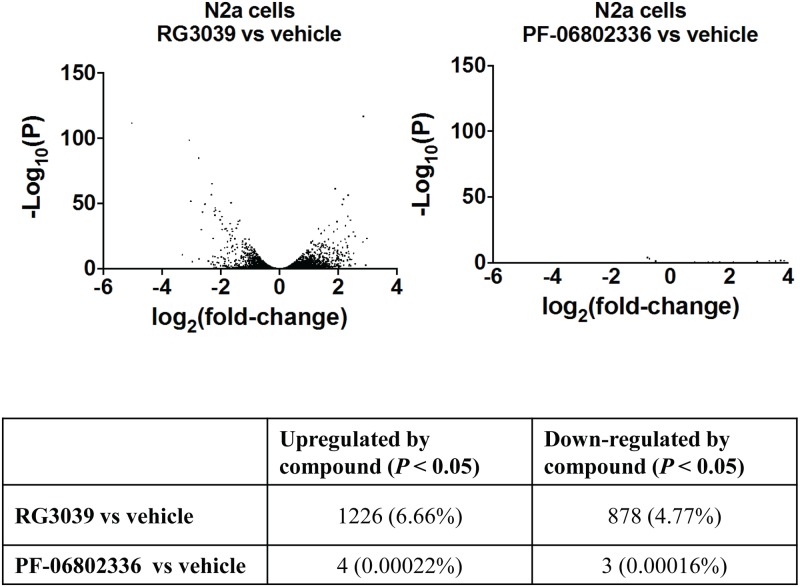
Volcano plots of differentially regulated genes detected by RNA-Seq analysis of N2a cells treated with RG3039 or its 7-methyl analog PF-06802336 with summary of number of genes significantly (P<0.05) changed.Plates of cells (in quadruplicate) were treated with 1 μM of either compound or DMSO (1 μM) for 24 hours before isolation of polyA RNA and RNA Seq analysis. In each case, the—Log10 of the corrected P value for the difference between compound- and DMSO-treated samples for each detectable gene was plotted vs the Log2 of the fold difference. The table summarizes the numbers of significantly (P<0.05) differentially-regulated genes irrespective of the fold change and as a percentage of the total numbers of genes detectable. A total of 18,409 genes were detectable.